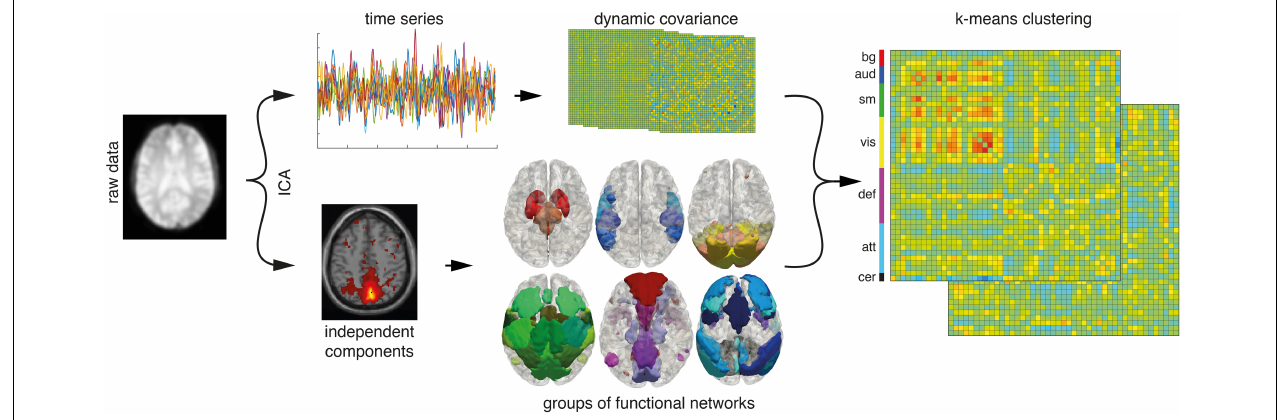
FIGURE 1 | Data analysis pipeline. An independent component analysis (ICA) separates the preprocessed signal into 75-time series (top row) and associated spatially independent components (bottom row). Time courses are sorted into functional groups. Two hundred sixty-seven dynamic covariance matrices are calculated from the time courses of signal components ( n = 57) in 30 frames time windows. K-means clustering sorts the matrices into seven patterns or clusters. bg, basal ganglia; aud, auditory; sm, somatosensory and motor; vis, visual; def, default mode; att, attentional; cer, cerebellar